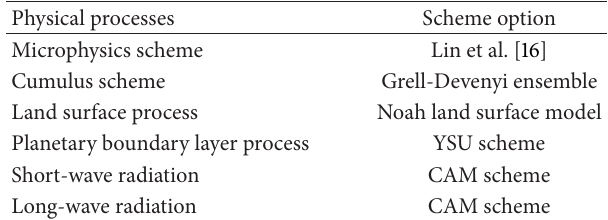
Table 2: Configuration of the physical parameterization schemes in